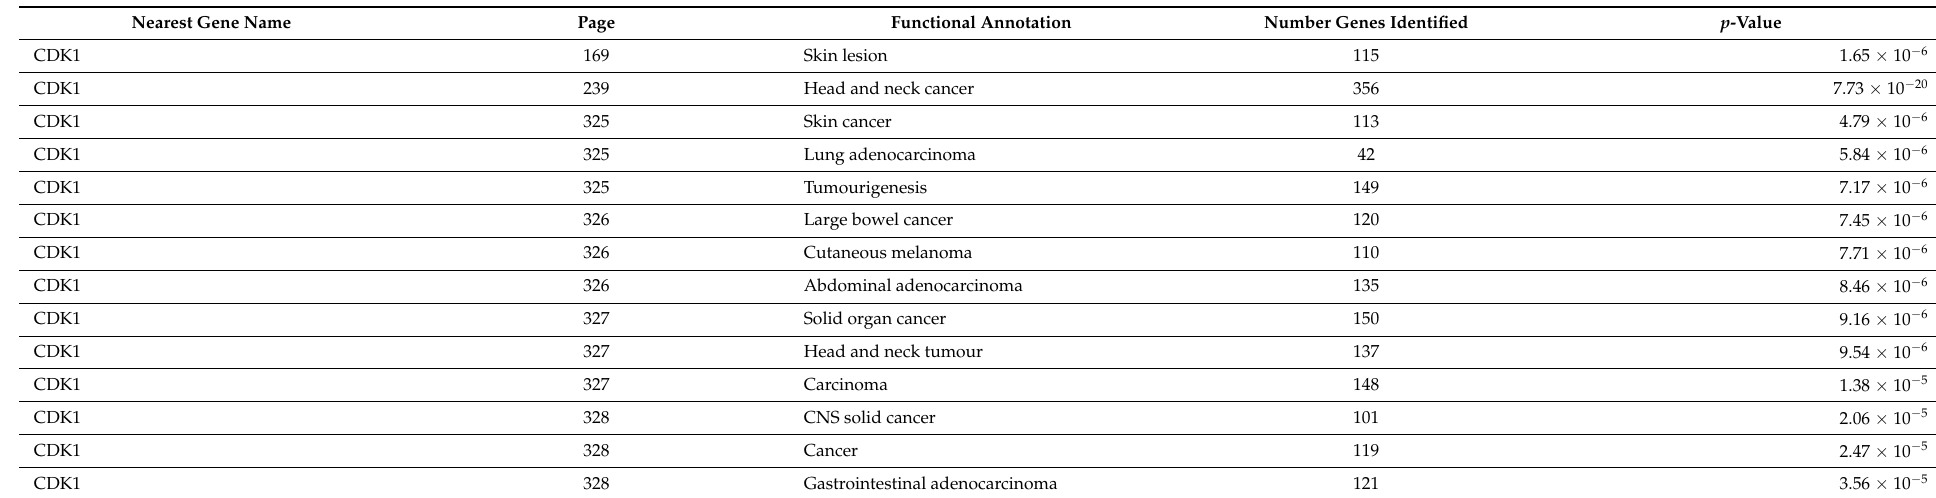
Table 15. Selected EWAS Hits on Cyclin Dependent Kinase 1; Data from Schrott